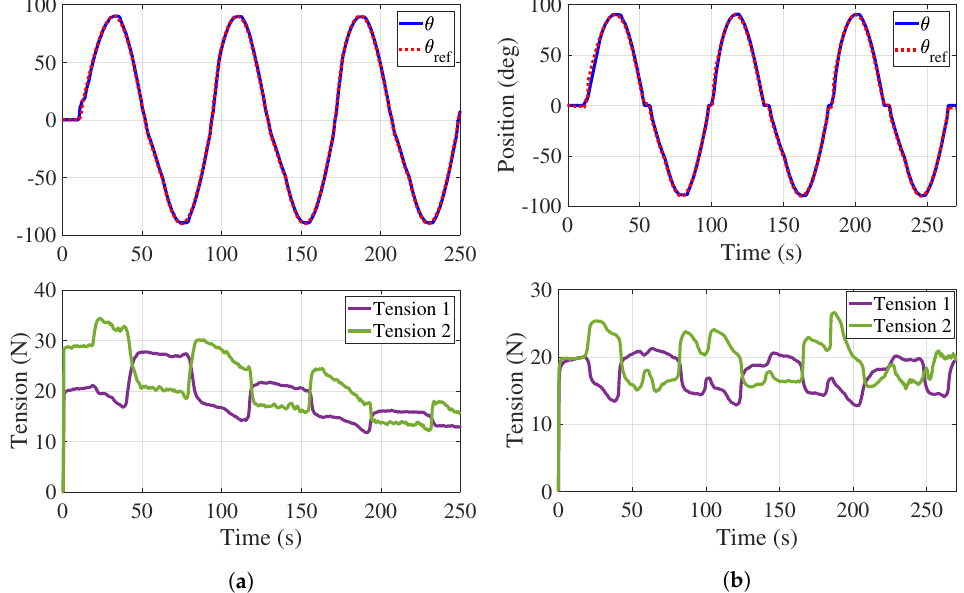
Figure 8. Passive phase. ( a ) Trajectory tracking without tension control with load. ( b ) Trajectory tracking with tension control with